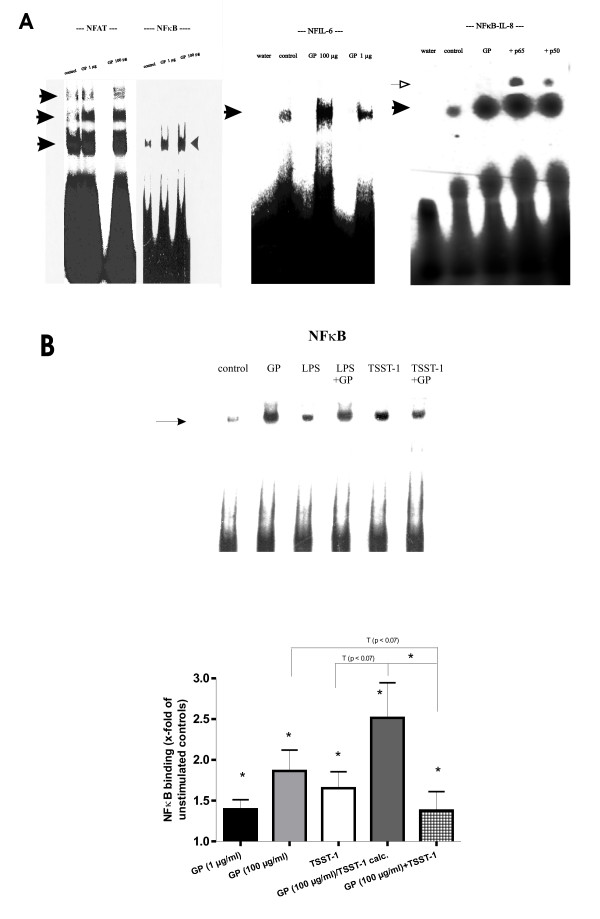
A, GP led to DNA binding of NFAT, NFκB and NFIL-6. Human PBMC were incubated with medium control or GP (1 and 100 μg) for 1 h at 37°C. Nuclear extracts were incubated with a 32P-labeled NFAT, NFκB, NFIL-6 or NFκB-IL-8 oligonucleotide probe corresponding to the IFNγ, TNFα, IL-6 and IL-8 gene promoters (Table 1). Arrows with the black head indicate migrational location of the NFAT-DNA, NFκB-DNA, NFIL-6-DNA or NFκB-IL-8-DNA complex compared to free probe (no shift). Arrow with the open head indicates a supershift of NFκB-IL-8-DNA-anti-p65 and -p50, respectively. An autoradiogram from a representative experiment is shown (n = 7). B, Decreased DNA binding of NFκB following GP + TSST-1, compared to TSST-1, GP, or TSST-1/GP. Human PBMC were incubated with medium control, LPS, TSST-1, GP (100 μg), GP + TSST-1 and GP + LPS for 1 h at 37°C. An autoradiogram from a representative experiment is shown. Schematic representation of NFκB-DNA binding activity following GP (1 and 100 μg) or TSST-1 treatment (250 ng) as well as simultaneous administration of both compounds and the theoretical value (GP/TSST-1 calc.). Medium control levels were set equal to 1± SEM and significances (* = p < 0.05) are shown with respect to medium control (n = 4).